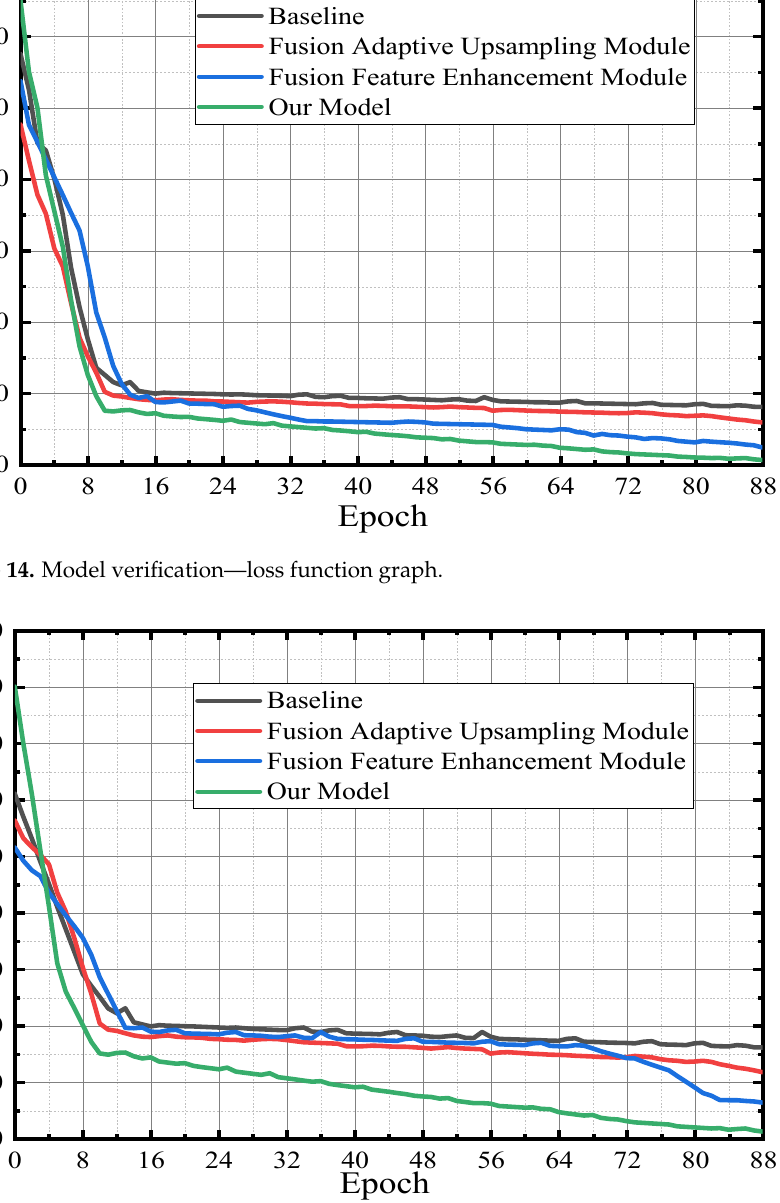
Figure 15. Model verification—loss function graph.